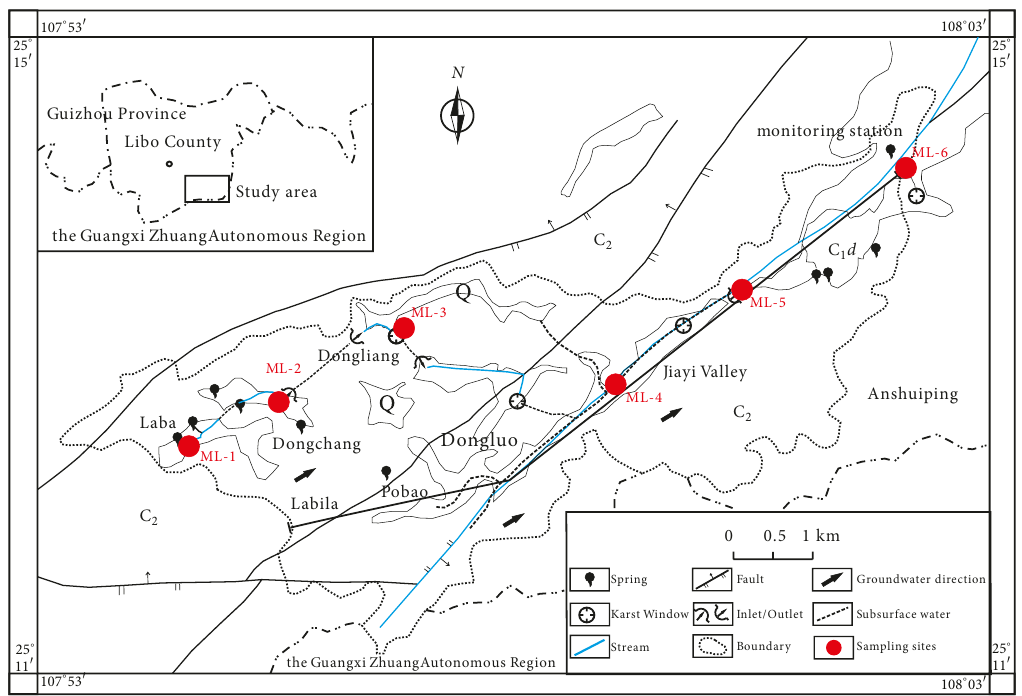
Figure 5: Hydrogeological map and location of sampling sites in the Banzhai subterranean river basin.